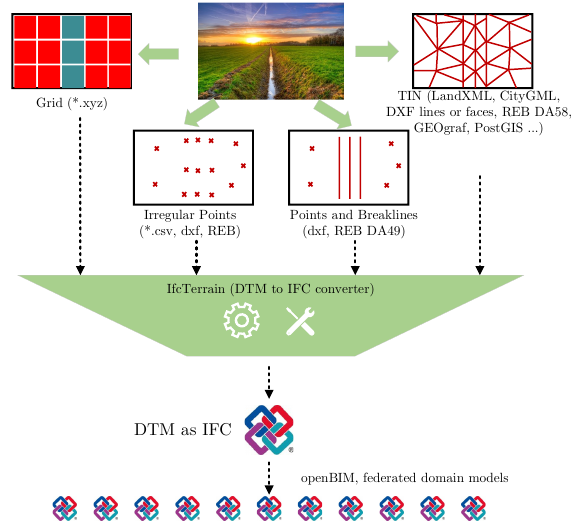
Figure 1. Workflow and dataflow from terrain to DTM to IFC to openBIM - upper part from (Romanschek et al.,